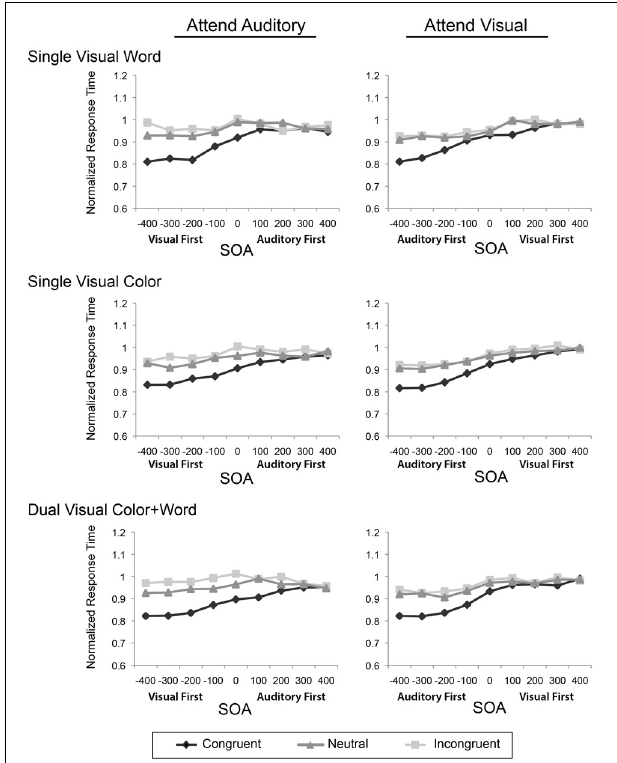
FIGURE 3 | Modality-normalized reaction times for the congruent, neutral, and incongruent conditions are plotted across the 9 SOAs, presented in separate rows for each visual feature combination, and in separate columns for the two attentional